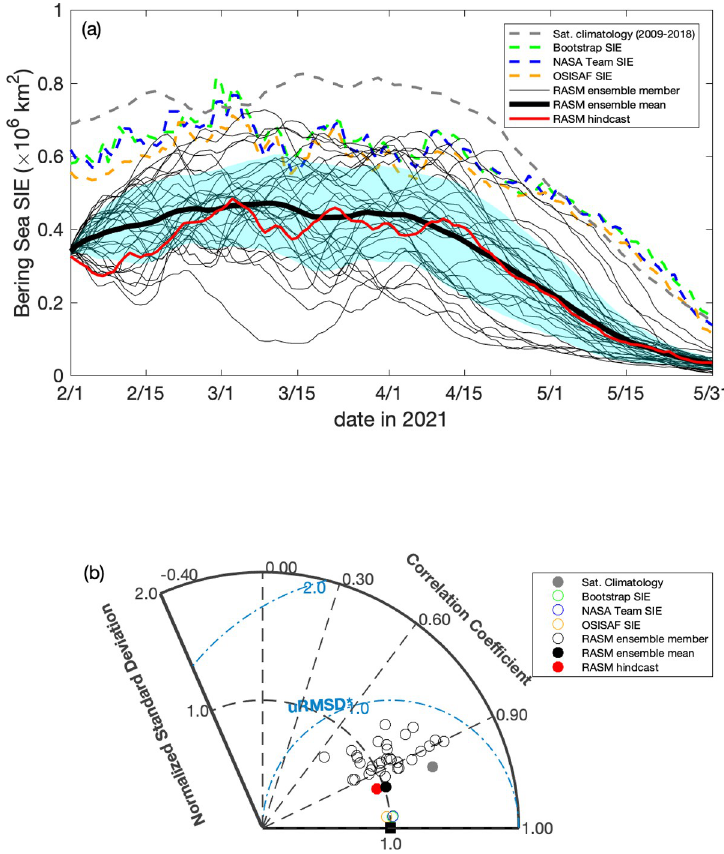
Fig 17. Daily sea ice extent during February–May, 2021 from RASM compared with satellite observations. (a) Daily timeseries of sea ice extent in the Bering Sea during February to May, 2021 from the RASM forecast, RASM hindcast, and satellite algorithms, with light blue shading representing 1 standard deviation from the forecast ensemble mean. The gray dashed line is the satellite-derived (Bootstrap, NASA NT, and OSISAF) daily climatology between 2009 and 2018. (b) Taylor diagram showing the normalized correlation coefficient (r), standard deviations ( σ ), and the unbiased root-mean-square difference (uRMSE) for the timeseries. The Taylor diagram illustrates a relative model performance in reproducing satellite-derived Bering Sea daily SIE variability, as well as the individual data sets, relative to the average of Bootstrap, NASA NT, and OSISAF products, represented by the black square as the reference where the normalized standard deviation and the correlation coefficient are 1.00 and the unbiased root mean difference is 0.00. Figure created using Matlab (v.